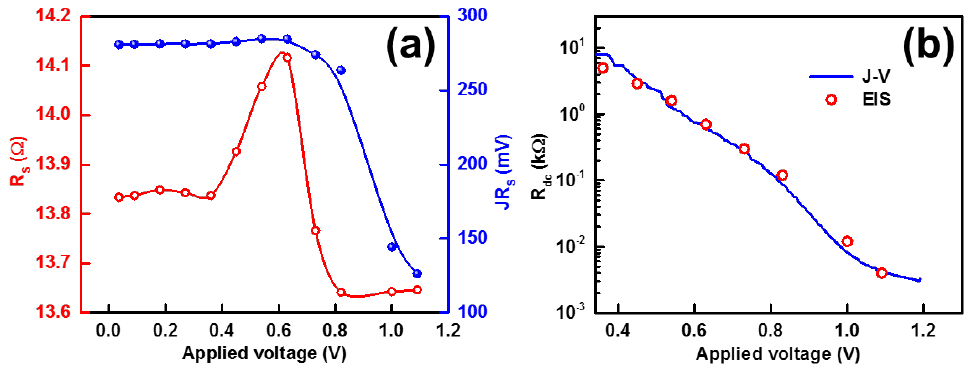
Figure 4. ( a ) Variation of series resistance R S depicted from the impedence spectroscopy (IS) measurements, and the voltage drop at R S under 1 sun illumination as a function of applied bias. ( b ) A comparative plot of total resistance calculated from IS and differential resistance from J-V characteristics measured under 1 sun illumination as a function of applied voltage.